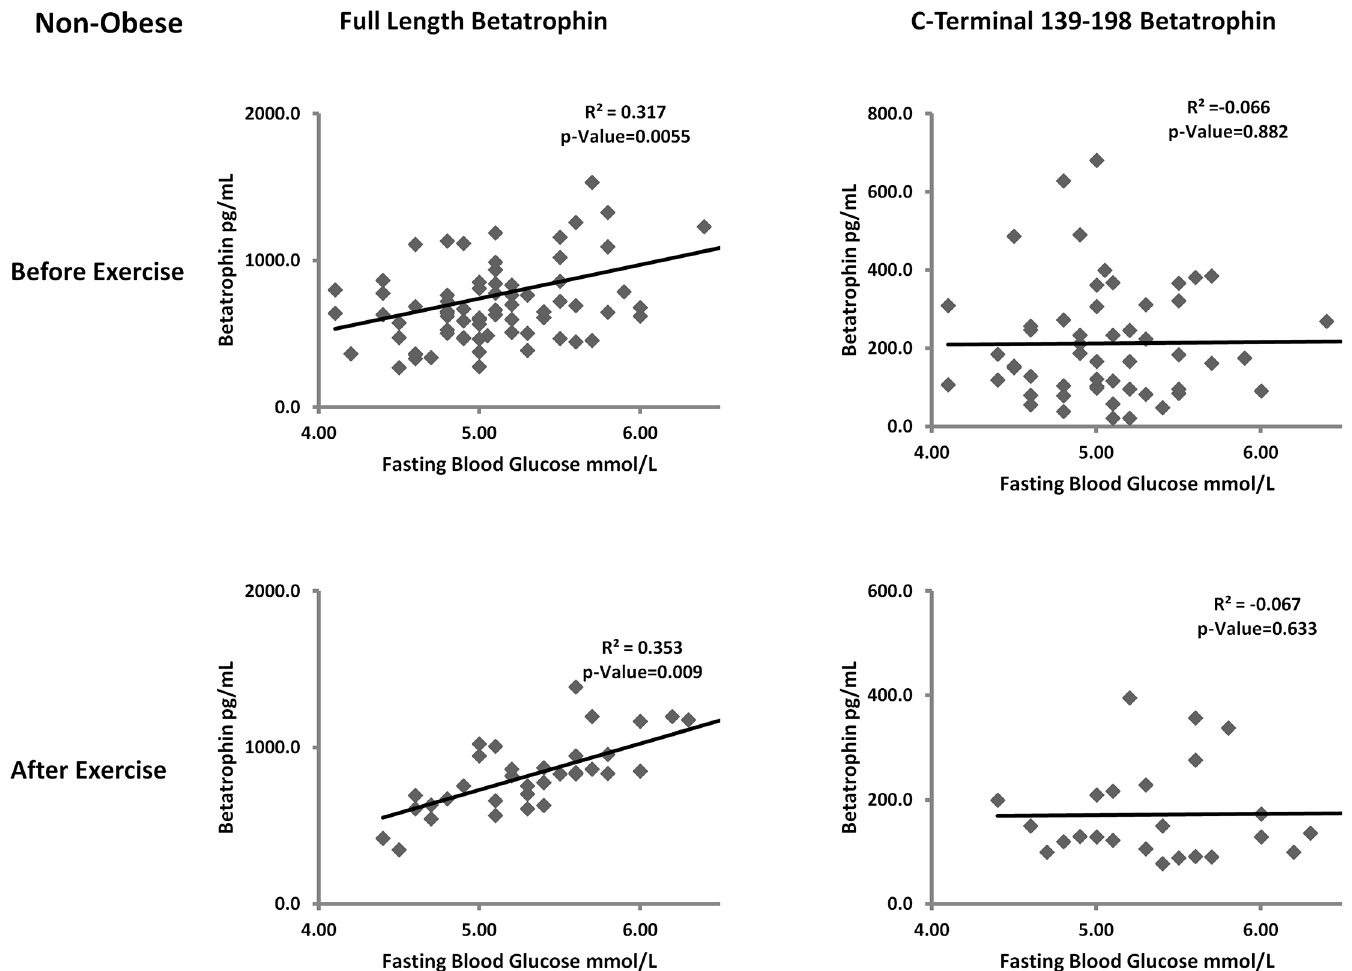
Fig 3. Spearman ’ s correlation between full length and C-terminal form of ANGPTL8 and FBG in non-obese subjects before and after exercise adjusted for age gender and